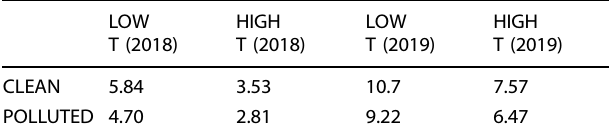
Table 1. March – April mean daily rainfall averaged over southern China in the WRF-Chem simulations for 2018 and 2019. The unit is mm day − 1